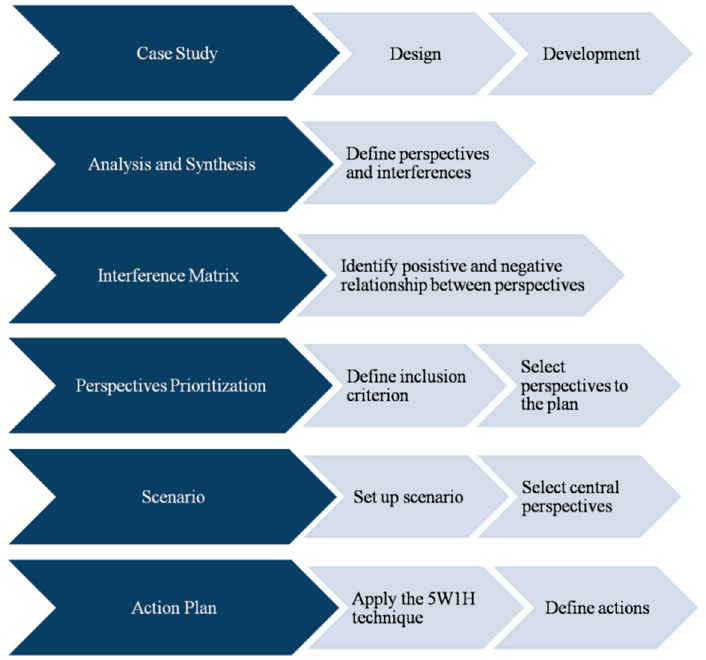
Figure 10. Methodology to Construct the Macro Action Plan.